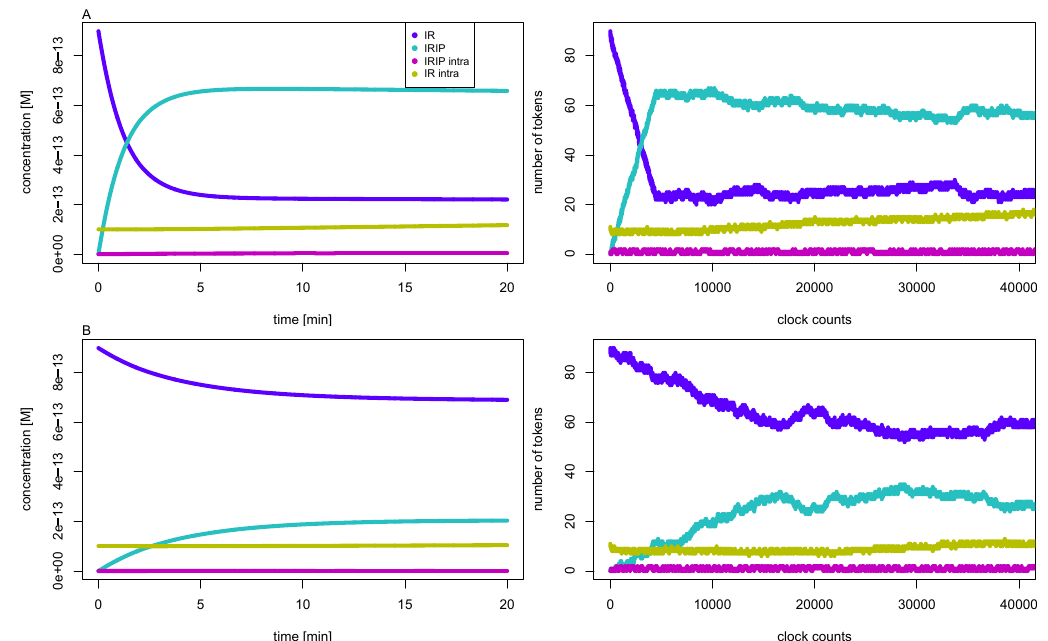
Figure 7. The left part depicts the concentrations of the IR (dark blue line), the phosphorylated insulin-IR complex IRIP (light blue line), the internalized complex IRIP (purple line), and the intracellular IR (yellow line) versus reaction time for intra intra initial insulin concentrations, 10 nM (part A, top), and 1 nM (part B, bottom), respectively. The concentrations are precise numerical simulations of the reaction system Equation (5). The right part shows the number of tokens versus the global clock time for the corresponding TPN. One token equates to a concentration of about 10 fM, and 2000 counts of the global clock time represent one minute reaction